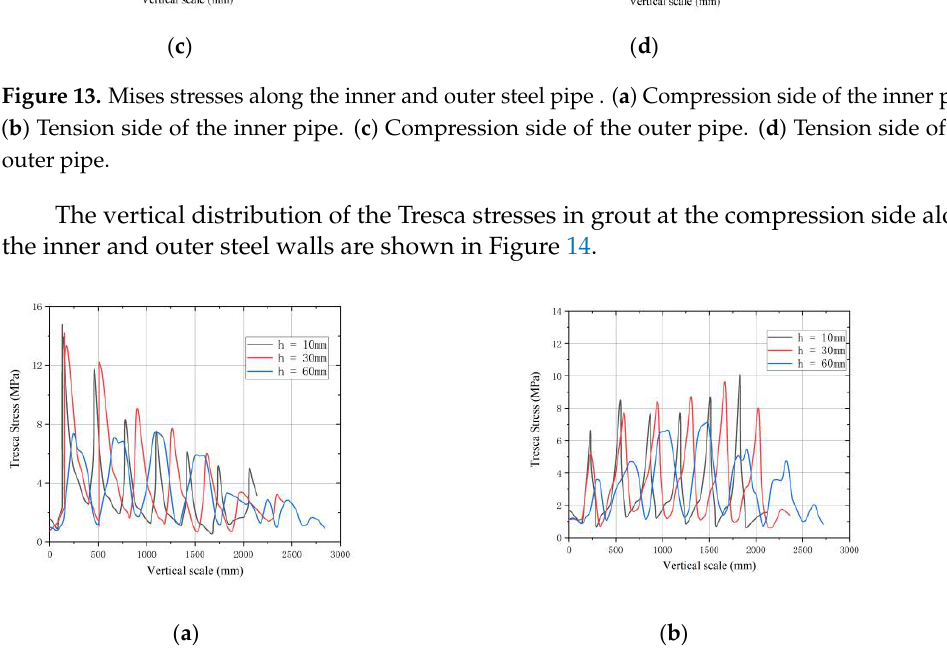
( b ) Figure 15. Variation trend of maximum stress/displacement of grouted joints with different shear bond widths. ( a ) Stress. ( b ) Displacement. In Figure 15, the maximum Tresca stress in grout decreased by 23.7% as the shear key width increases from 20 mm to 60 mm, and the maximum horizontal displacement of grouted joints decreased by 20%. Therefore, appropriately increasing the shear bond width can reduce the maximum stress and horizontal displacement of grouted joints. 4. Conclusions In this paper, the FE models of the grouted joints of offshore wind turbine tower is established based on plastic damage theory. The reliability of the simulation method is verified by comparing the simulation results with the test results in the aspects of load- displacement curve, ultimate bearing capacity and failure process. The relationships be- tween the mechanical performance of the grouted joints and the shear keys with different